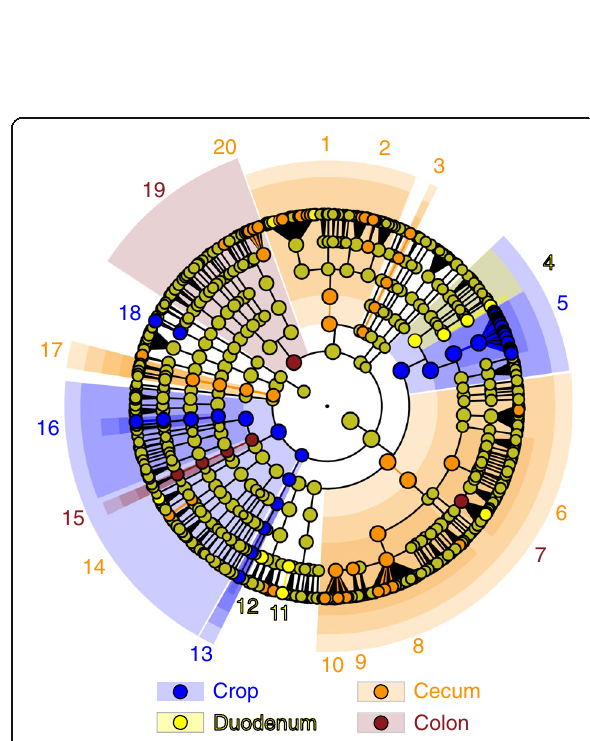
Fig. 3 LEfSe results illustrating the lowest-level nested taxa from phylum to genus associated with significant differences in microbiota composition among gut regions: 1 Bacteroidales , 2 Alistipes , 3 uncl. Flavobacteriaceae , 4 Staphylococcus , 5 Lactobacillus ,